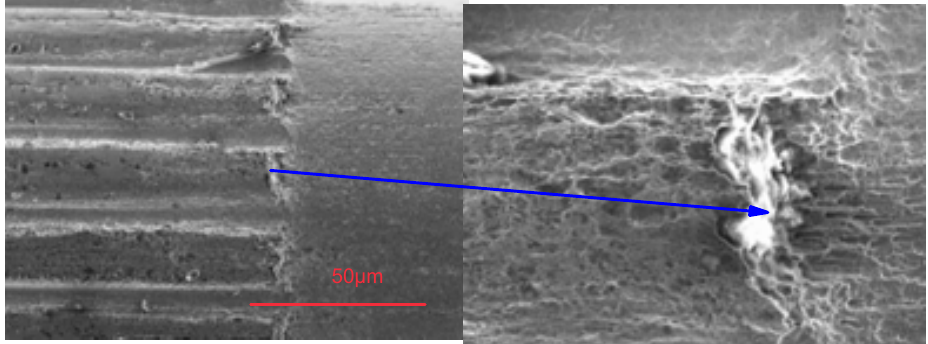
Figure 29. Corrosion in the grooves of the knurled pin after 45 cycles. Scale = 100 µ m. Sample